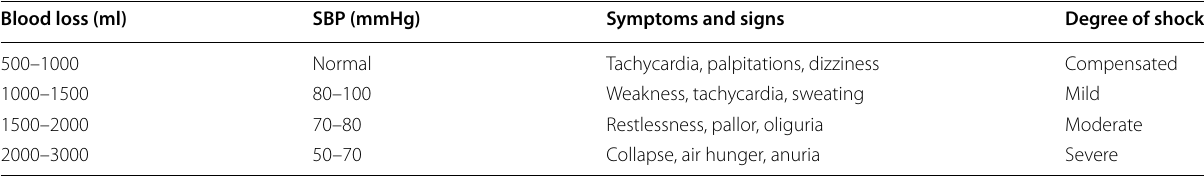
SBP Systolic blood pressure